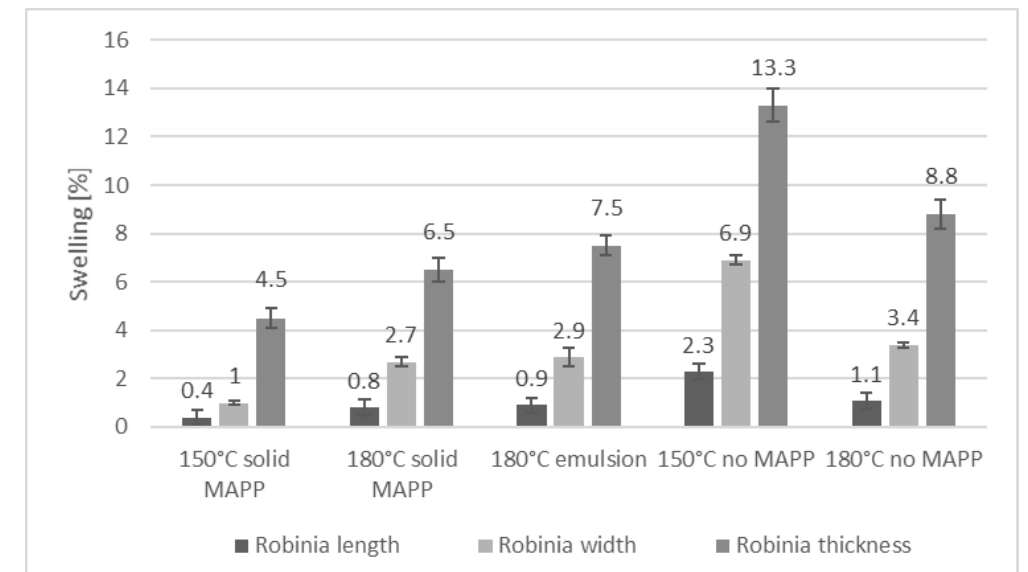
Figure 7. Swelling of composites with TMP based on Robinia after five hours submersion in boiling water. For comparison, values for composites with wood flour (softwood) were 0.3% (length), 0.7% (width) and 3.5% (thickness) including MAPP (solid), and 2.3% (length), 8.2% (width) and 16.0% (thickness) excluding MAPP.